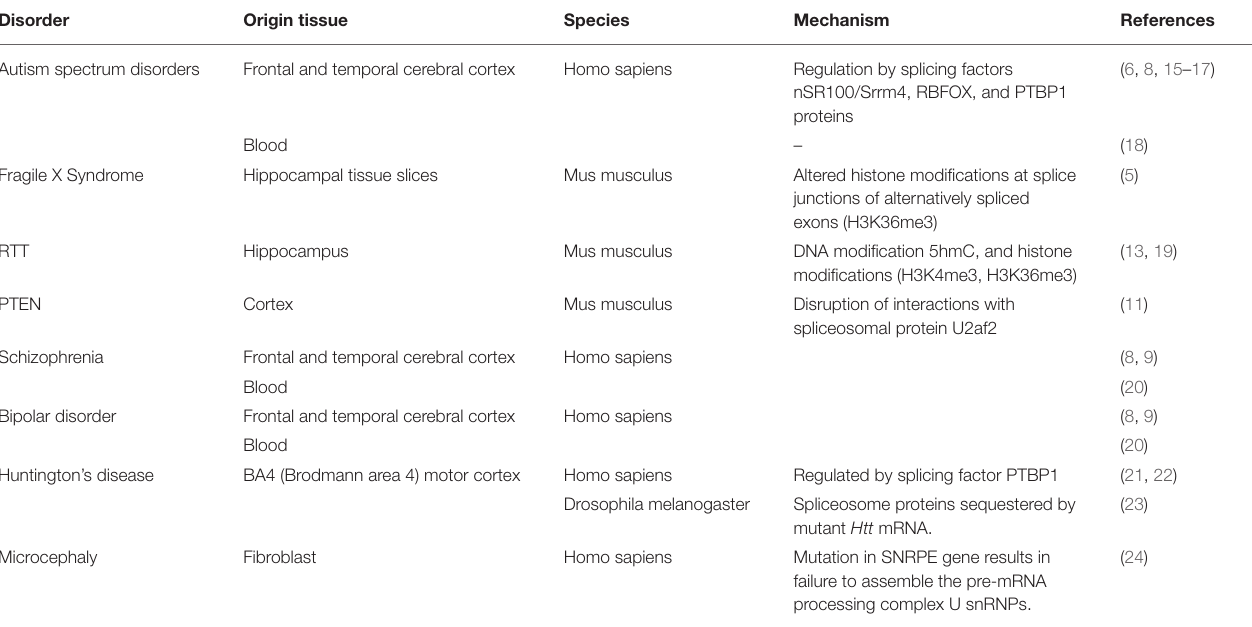
TABLE 1 | Evidence of differential alternative splicing in several neurodevelopmental disorders.